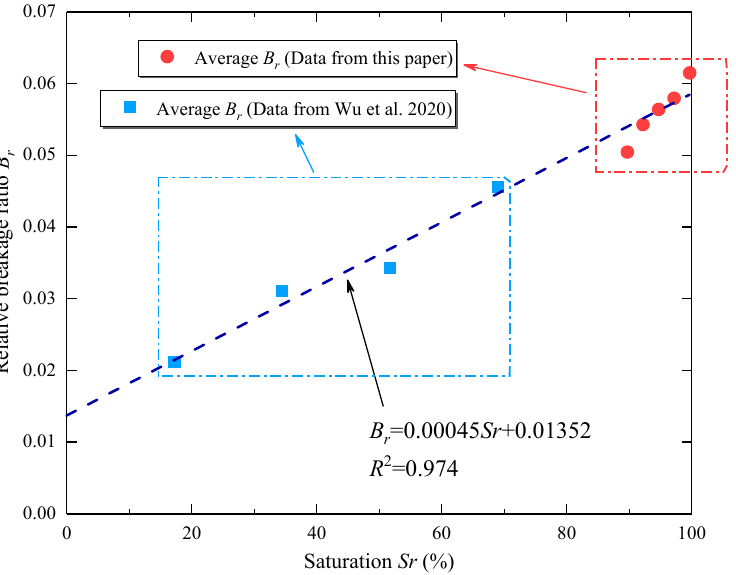
Figure 17. Relationship between relative breakage ratio and saturation combined with data from Wu et al. [9].